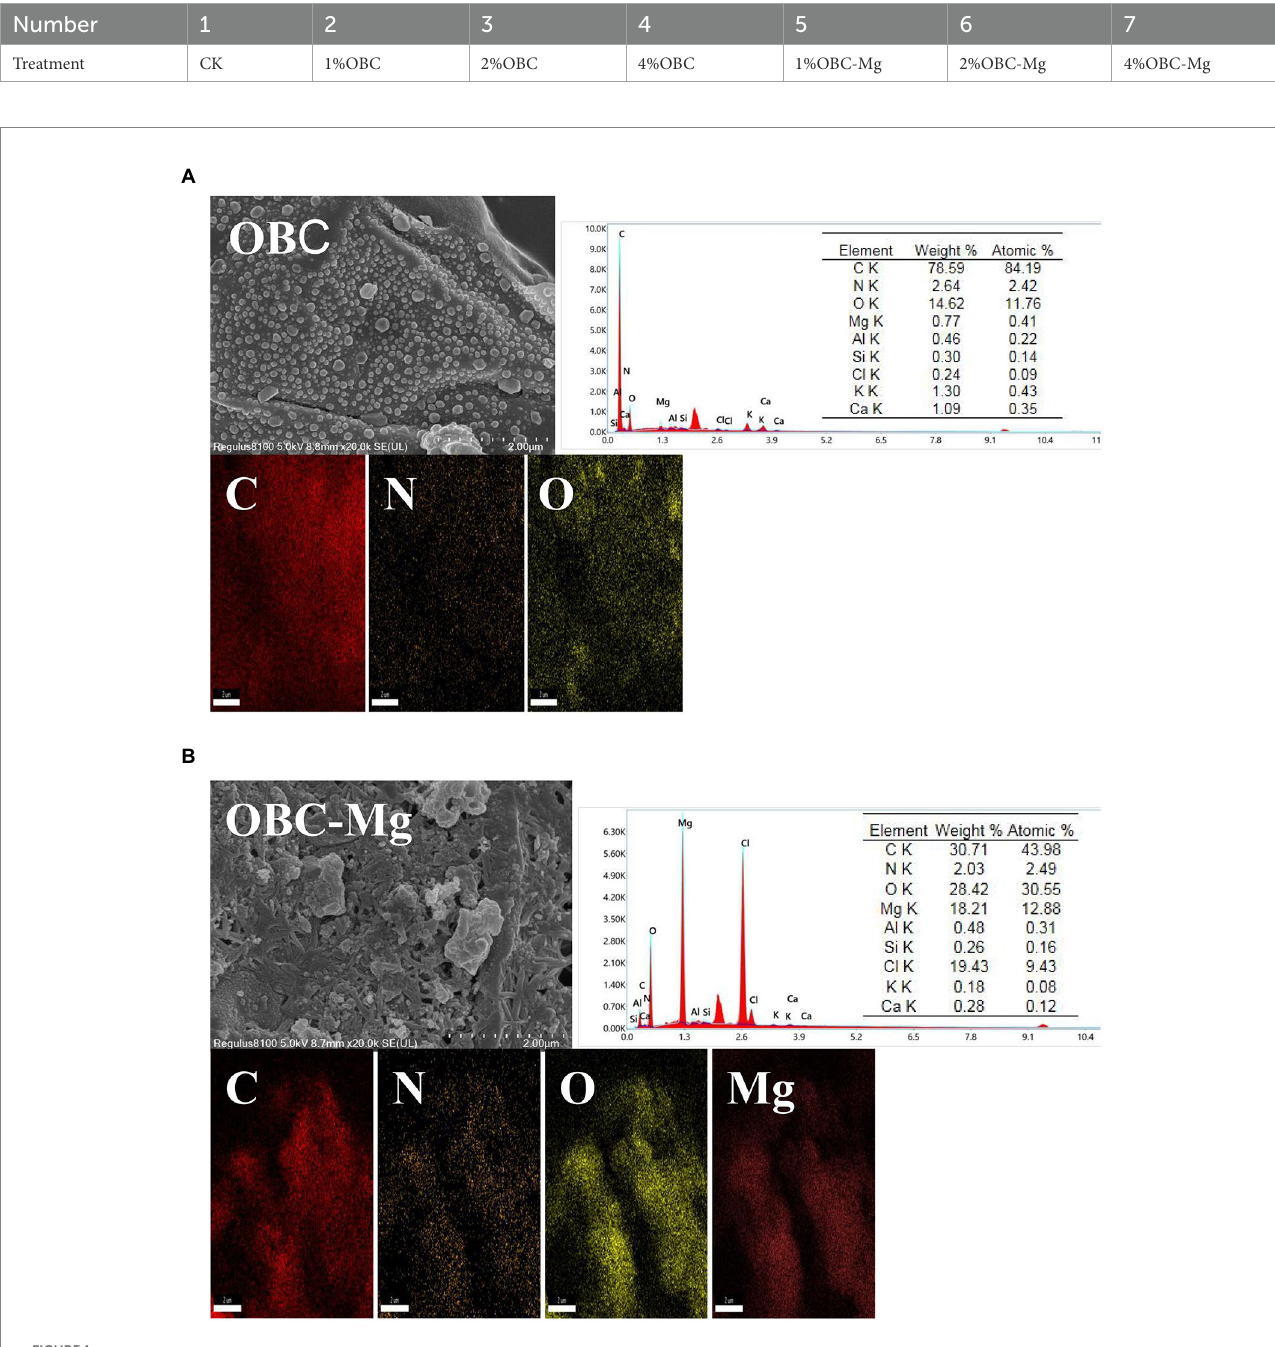
FIGURE 1 scanning electron microscopy–energy dispersive X-ray spectroscopy (SEM–EDS) analysis of (A) citrus peel biochar (OBC) and (B) magnesium-modified citrus peel biochar